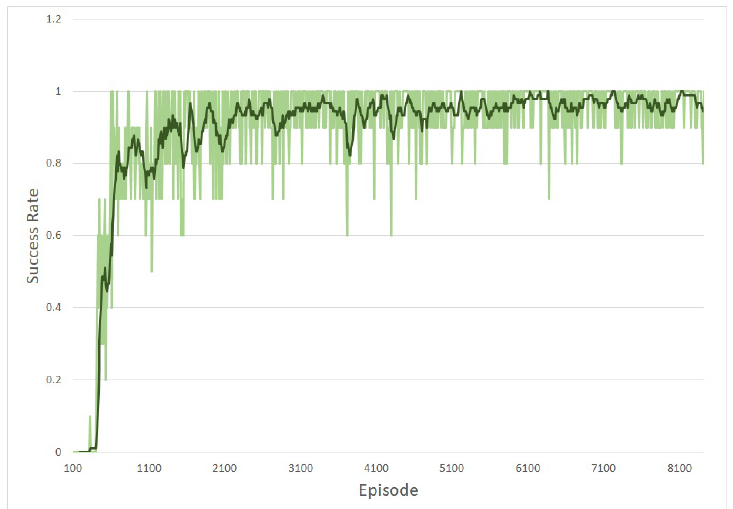
Figure 4. 2-DOF manipulator: success ration of reaching the goal point with